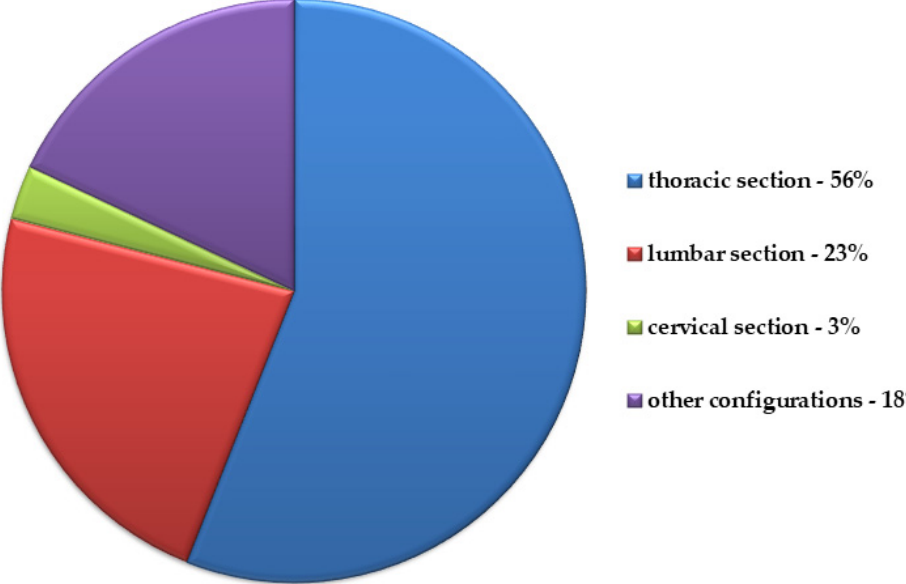
Figure 1. The frequency of metastases in individual sections of the spine based on data from ref. [6]. Paget’s “seed and soil” model explains the pathogenesis of spine metastases. It assumes that a seed symbolizes cancer cells and that soil is a specific place where they can multiply. Bone tissue is a site of dynamic metabolic changes, making it a privileged location for developing neoplastic metastases. These constant changes are propelled by the opposing functions of osteoclasts, which lead to bone resorption, and osteoblasts, which promote bone formation. The bone matrix is rich in various growth factors, which can be used as a result of bone turnover by the tumor to multiply faster. It was also noticed that metastases develop well in bones where the trabecular structure predominates and bones containing bone marrow, such as vertebrae and epiphyseal parts of long bones. In the trabecular system in blood vessels, blood perfusion is slower, and the walls are more permeable, promoting neoplastic cells’ retention